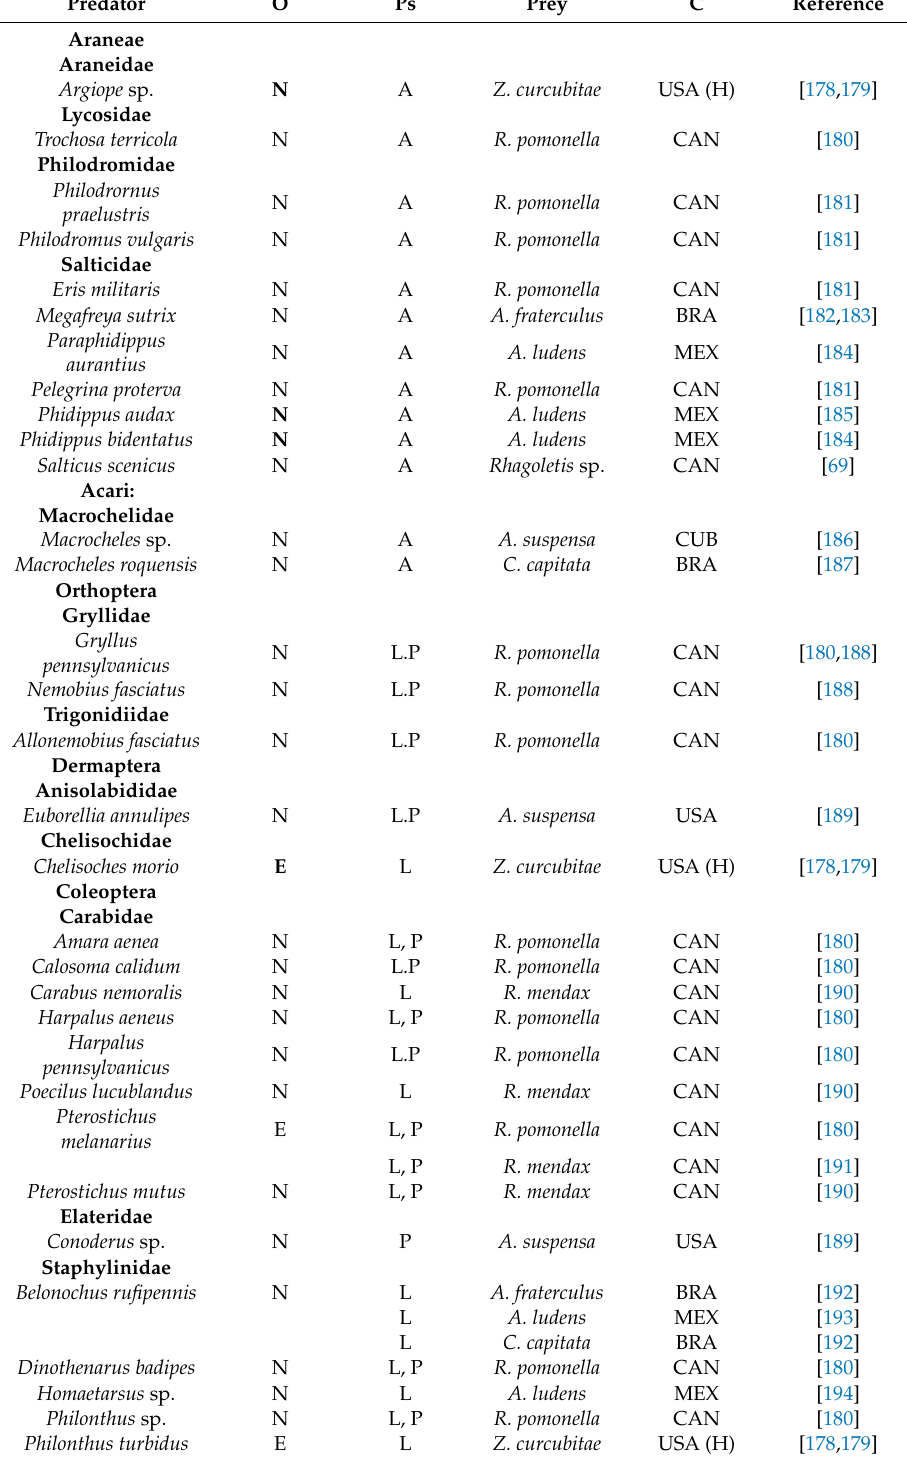
Table 8. Predators of fruit flies in the Americas and